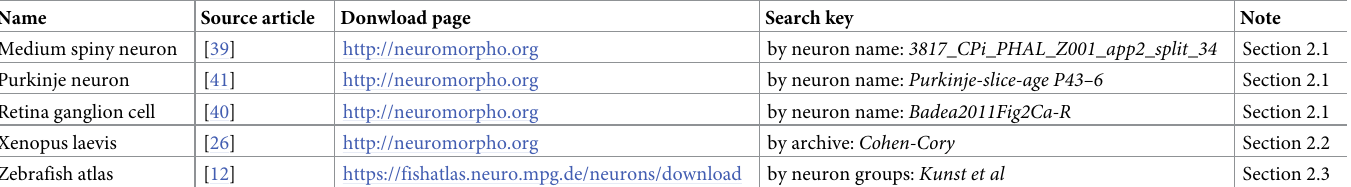
Table 1. Origin of the traces reanalysed in this